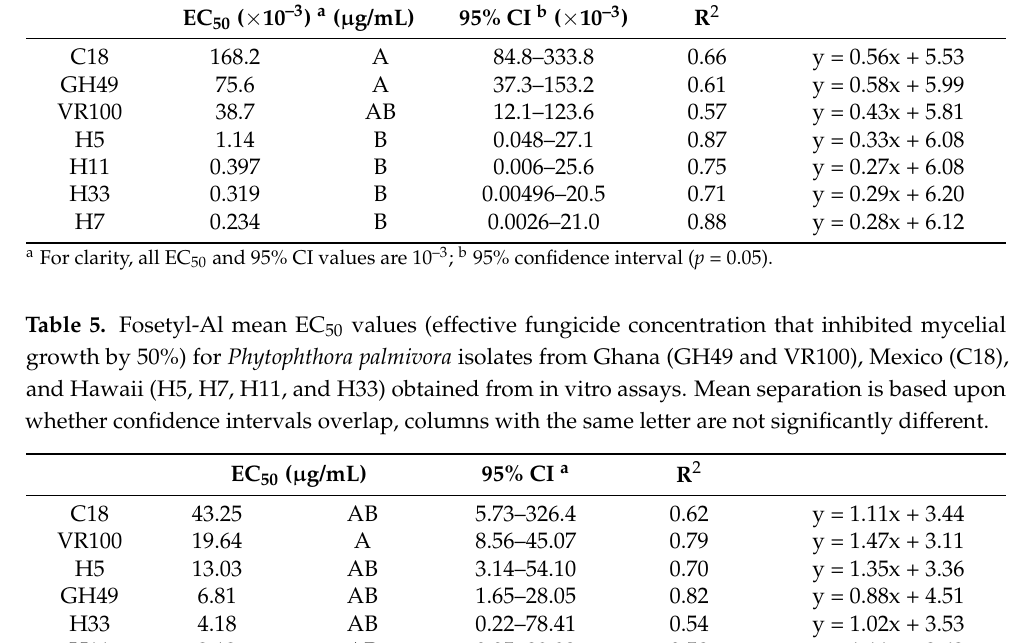
Table 4. Mefenoxam mean EC 50 values (effective fungicide concentration that inhibited mycelial growth by 50%) for Phytophthora palmivora isolates from Ghana (GH49 and VR100), Mexico (C18), and Hawaii (H5, H7, H11, and H33) obtained from in vitro assays. Mean separation is based upon whether confidence intervals overlap, columns with the same letter are not significantly different. EC 50 ( × 10 –3 ) a ( µ g/mL)